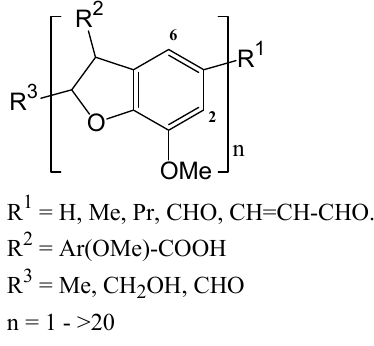
Figure 7. Tentative general formula of recondensed alfa organosolv lignin.